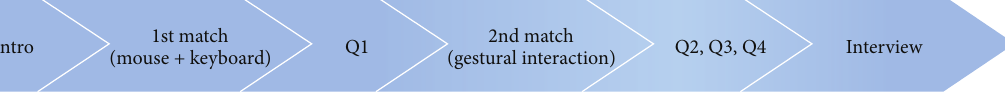
Figure 1: Activity flow.